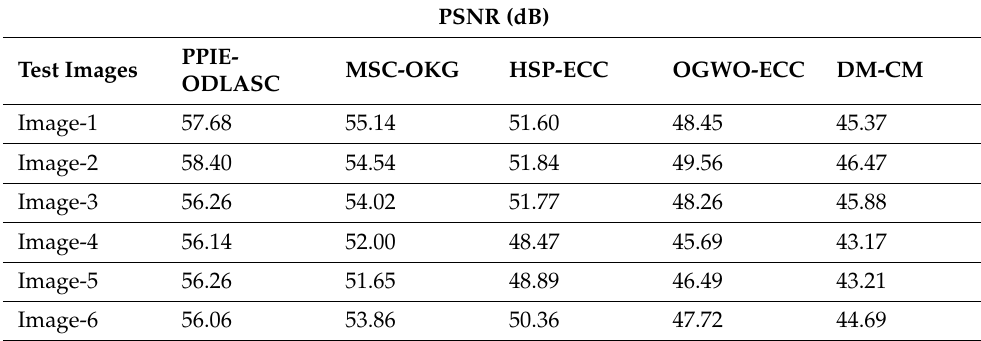
Table 4. PSNR analysis of the PPIE-ODLASC system with other approaches under different images. PSNR